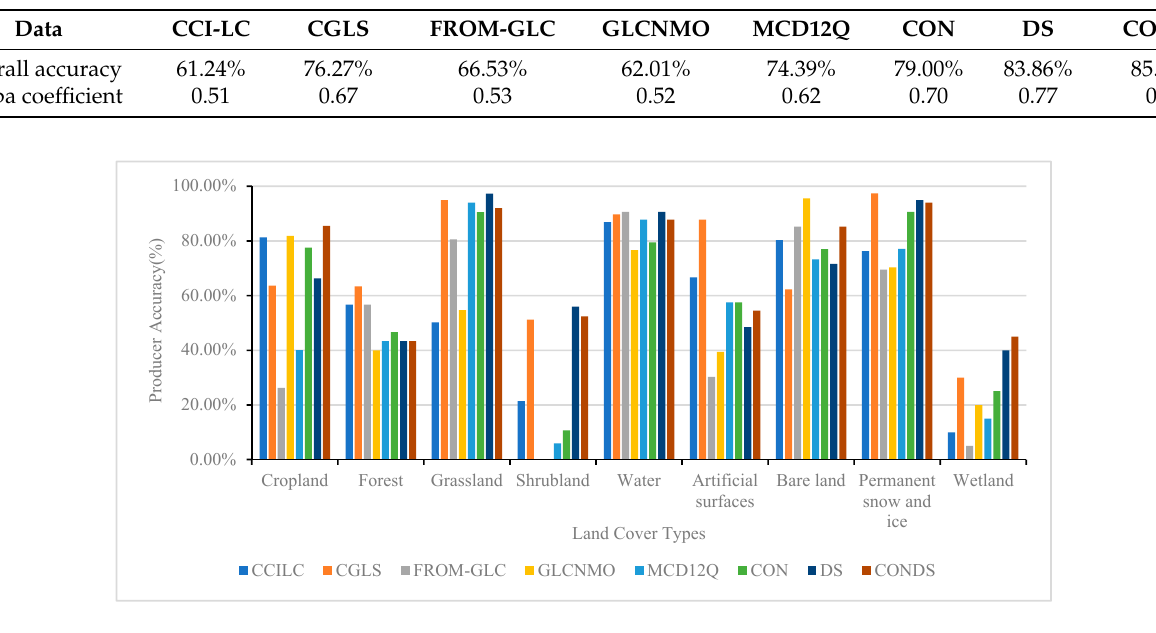
Figure 6. Producer accuracy of landcover products and fusion results.